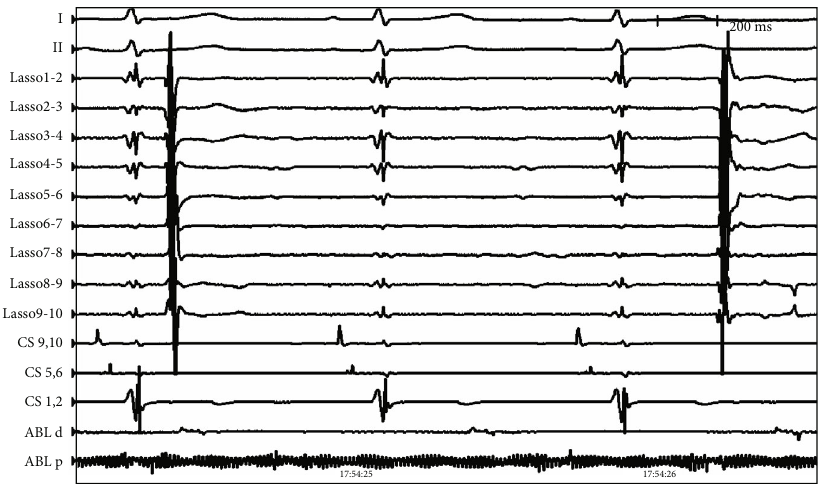
Figure 4: Intracardiac electrograms showing slow spontaneous potentials within the LAA after LAA electrical isolation (lasso in the LAA, no cardioversion